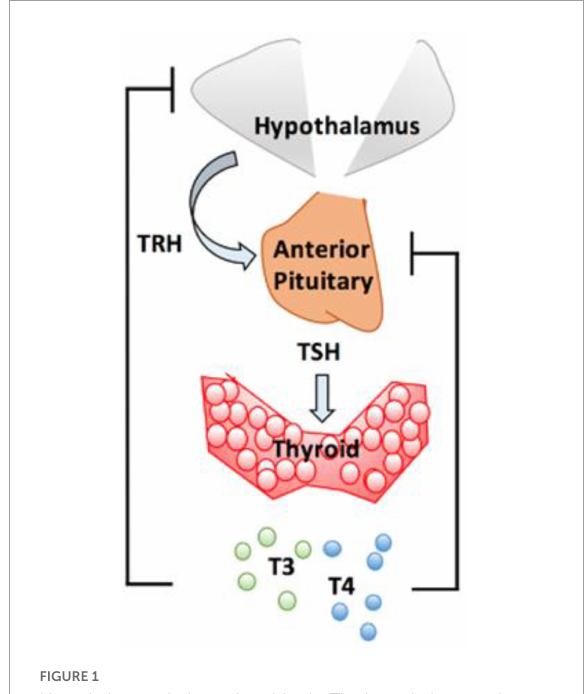
FIGURE1 Hypothalamo-pituitary-thyroid axis. The hypothalamus release thyrotrope releasing hormone (TRH) which stimulates pituitary thyrotrope cells to release thyroid stimulating hormone (TSH). TSH promotes production and secretion of T4 and T3. From J. Clin. Med. 2020, 9(6),